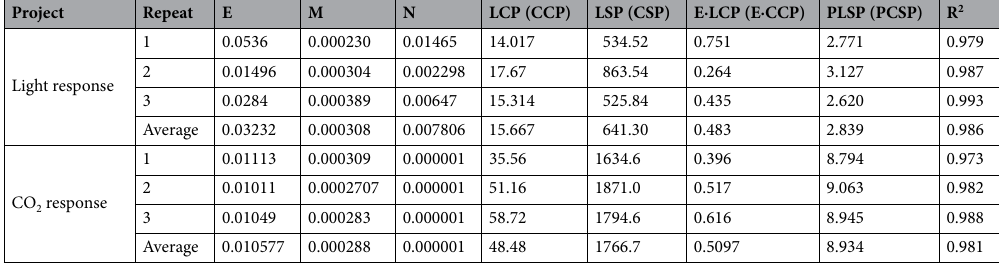
Table 3. Results of fitting light response curves and CO 2 response curves. LCP is light compensation point, unit: µmol m −2 s −1 . CCP CO 2 compensation point, unit: µmol mol −1 . CSP is CO 2 saturation point, unit: